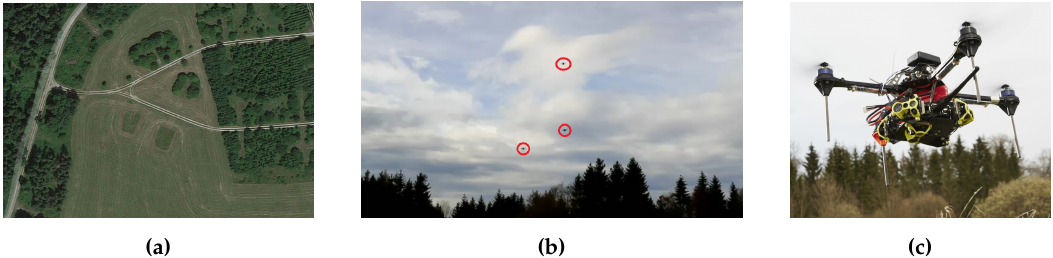
Figure 7. Experimental setup to evaluate our system design. ( a ) Aerial image of the area in which we carried out the experiments. ( b ) Three drones flying while they take images of a ROI. ( c ) One of the Astec Hummingbird quadcopters that we used for the